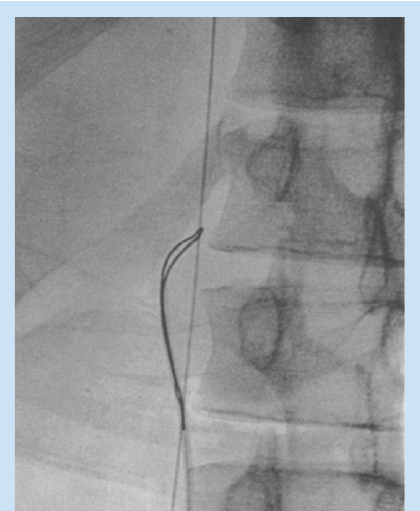
Fig. 4b. Guidewire in